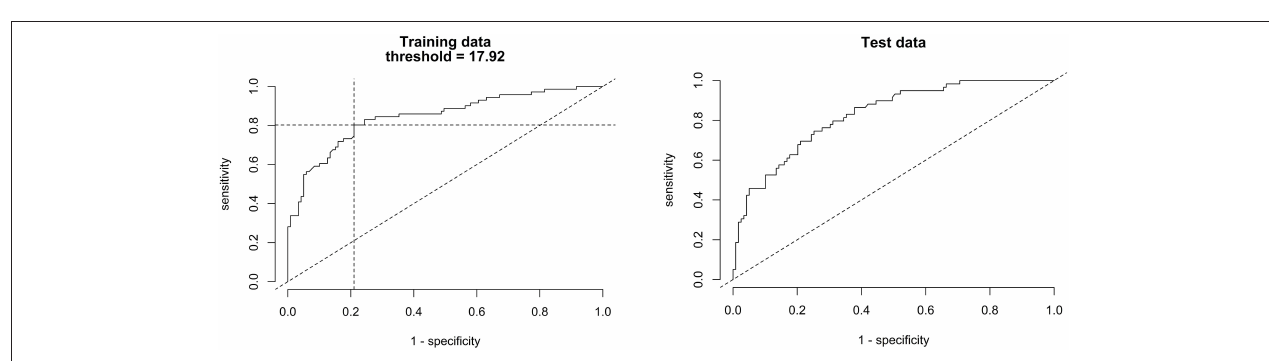
FIGURE 7 | ROC curves of PTT respiratory swing (training and test data) compared with a multi-channel study used to detect OSA or